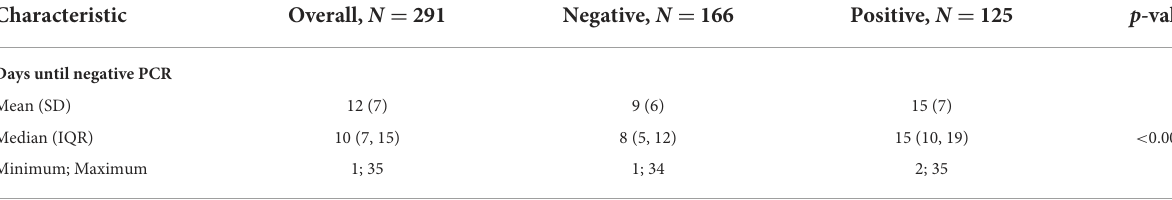
TABLE 7 Days until negative PCR in comparison with Panbio RAD test